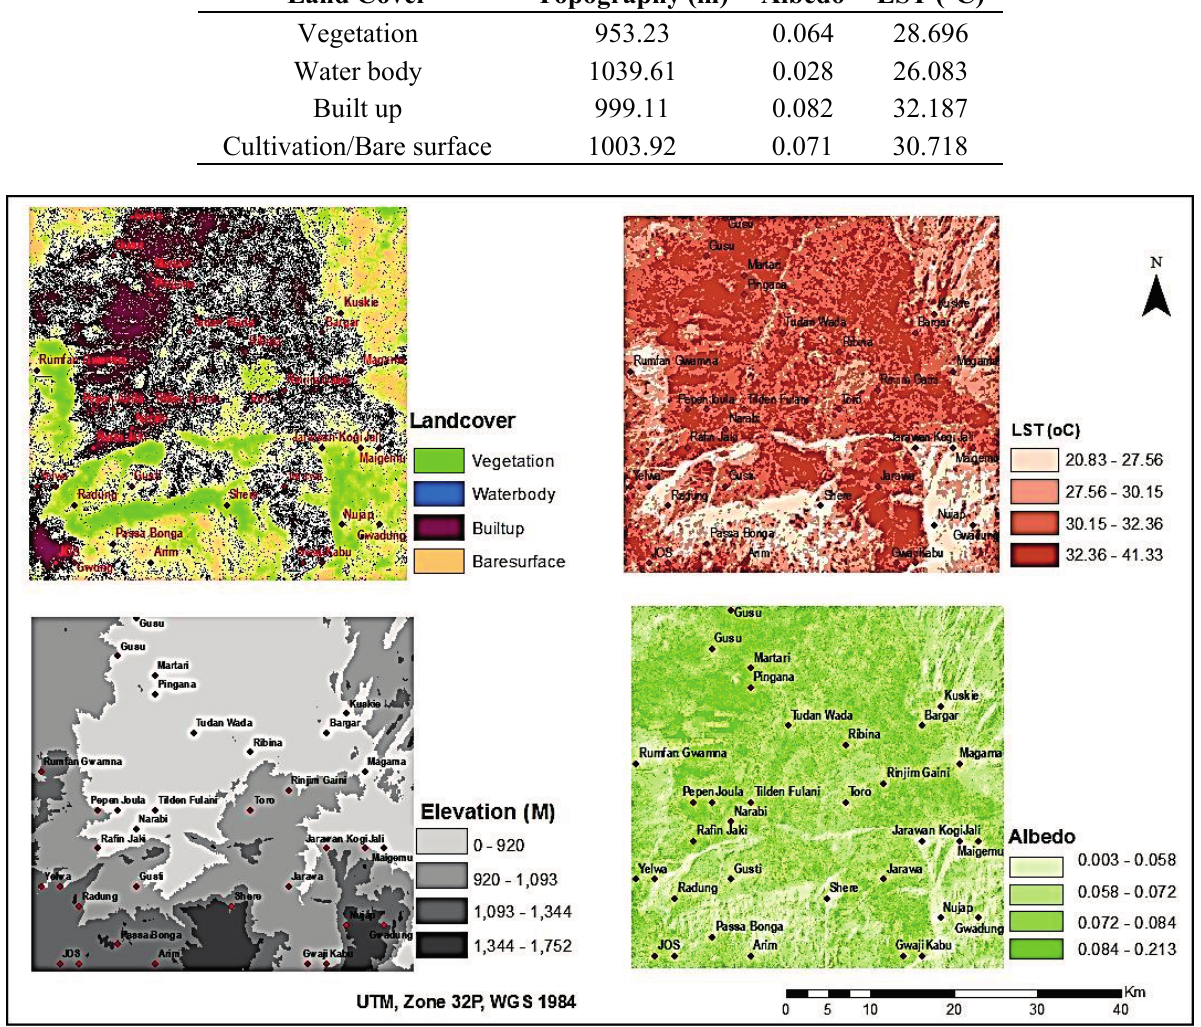
Figure 10. Landcover, LST, topography and albedo in Jos in